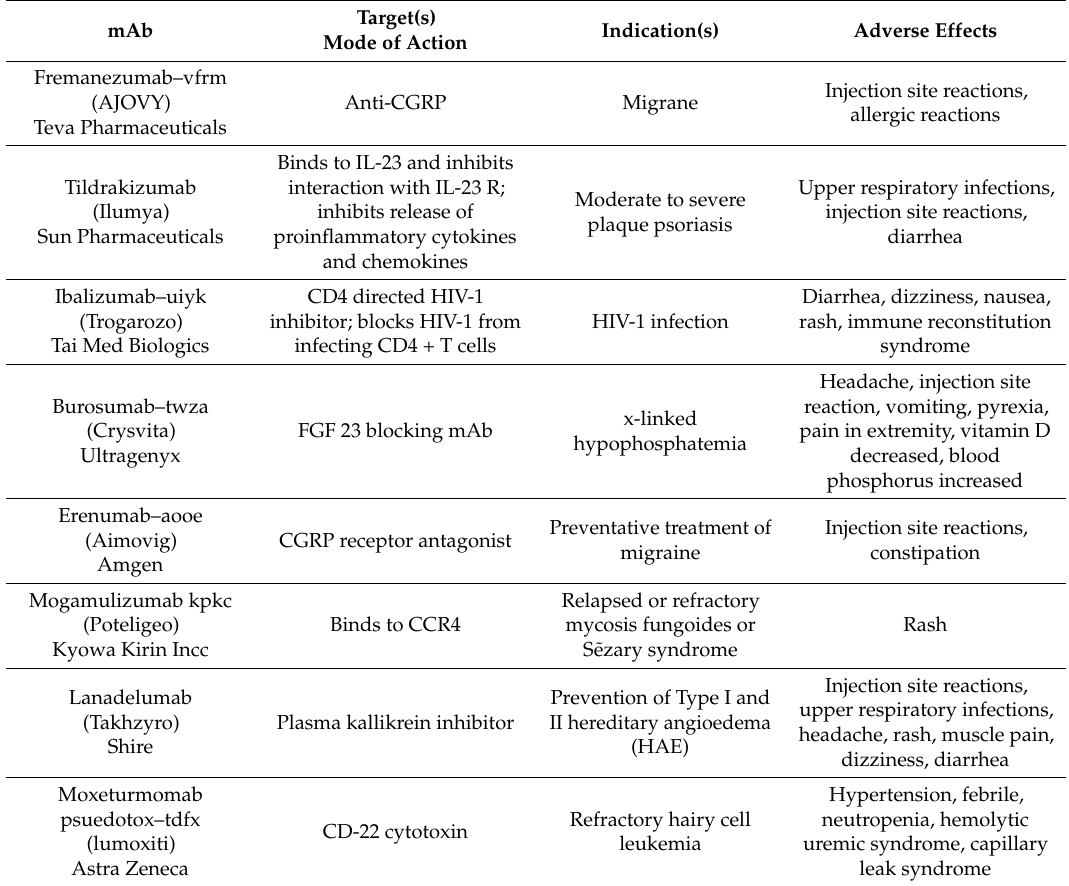
Table 2. USFDA mAb Approvals through 3Q